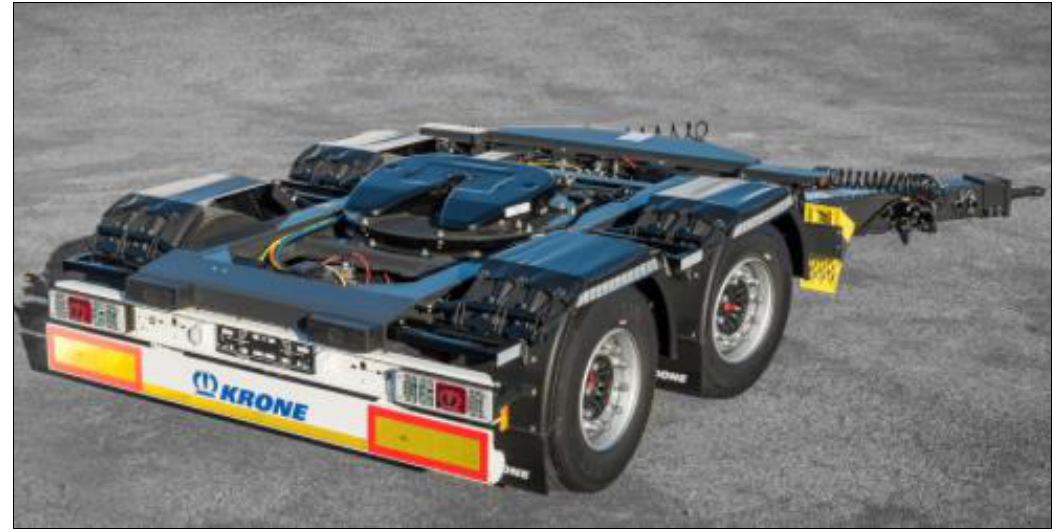
Figure 3. A two axles dolly (Krone, 2017 [5]).